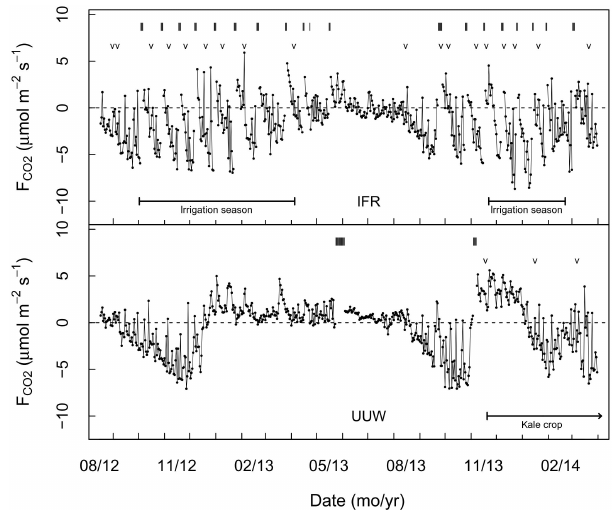
Figure 3. Time series of the daily mean CO 2 flux (net ecosystem exchange) at the IFR site (top) and the UUW site (bottom). Grazing times are indicated by bars near the top of each panel. The times of fertiliser applications are marked by “v” symbols.